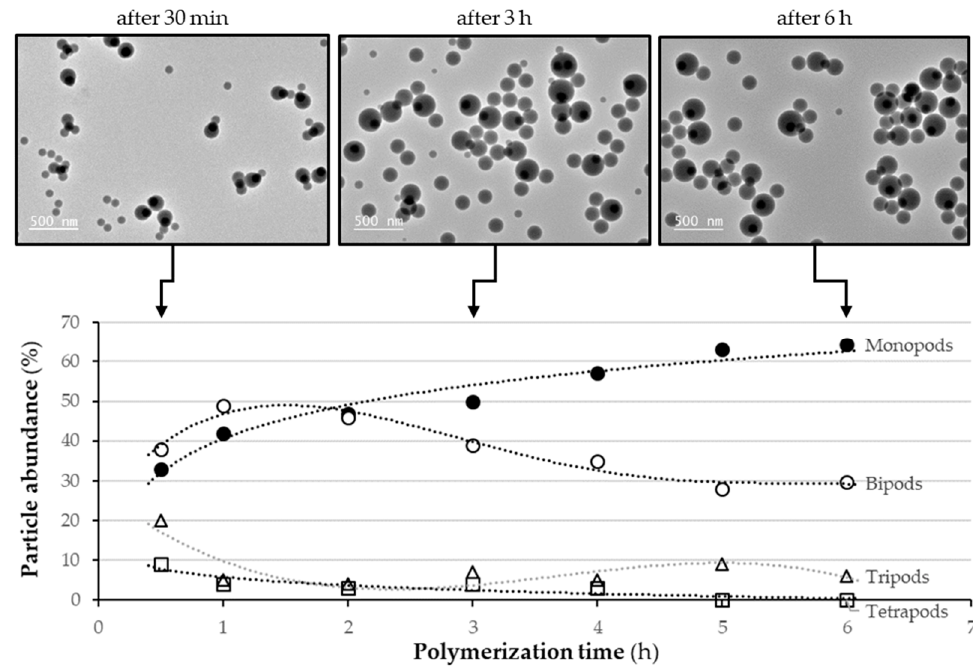
Figure 3. Graph showing the evolution with polymerization time of the abundance of the four main types of silica/PS nanoparticles as observed by TEM from silica seeds with d MPS = 0.5 funct./nm 2 , and representative TEM images taken after 30 min, 3 h and 6 h. Experimental conditions: [100-nm silica] = 7.3 × 10 15 part./L; [styrene] = 89 g/L; [Synperonic ® NP30] = 2.85 g/L; [SDS] = 0.15 g/L; [Na 2 S 2 O 8 ] = 0.46 g/L and 70 °C. The dash-dotted curves are a guide for the eye.